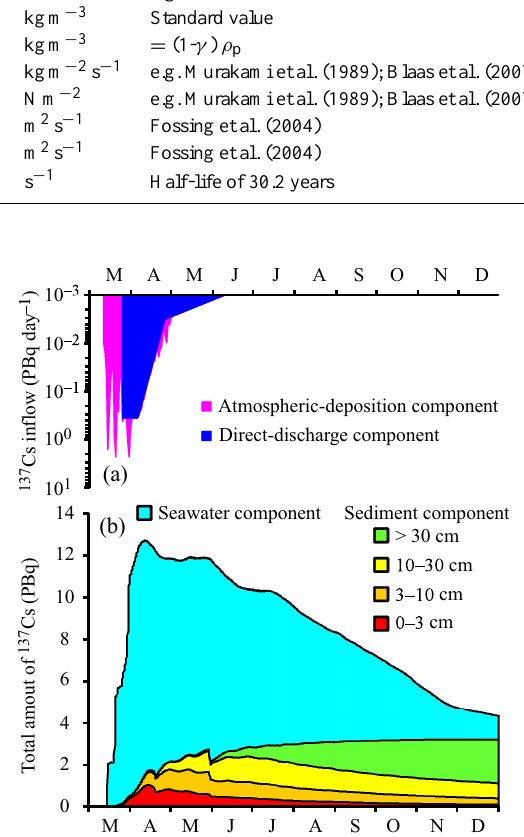
Figure 3. Time series of (a) 137 Cs inflow rates of atmospheric de- position and direct discharge from 1FNNP and of (b) total amounts of 137 Cs in seawater and sediment over entire simulation domain of Region-2. Both time series are denoted by stacked graph.